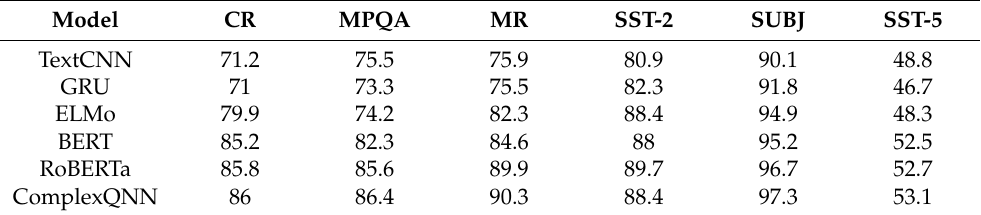
Table 3. Experimental results on six benchmarking sentiment-classification datasets evaluated with